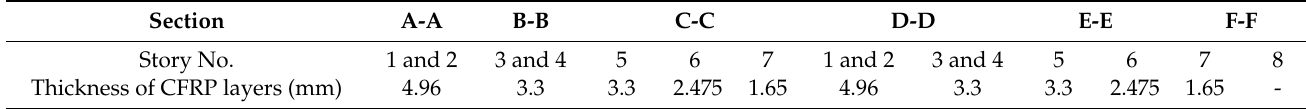
Table 3. Exterior and interior joints and the FRP sheet thicknesses at each joint [3].